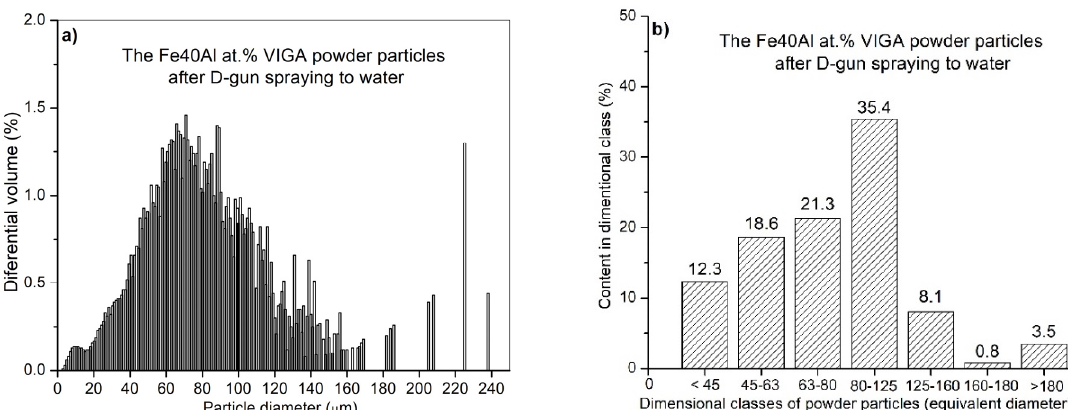
Figure 12. Analysis of the particle diameter distribution of the Fe40Al at.% (VIGA) powder using an IPS UA analyzer after state: volumetric fraction ( a ), fraction of particles in specific size classes ( b ).